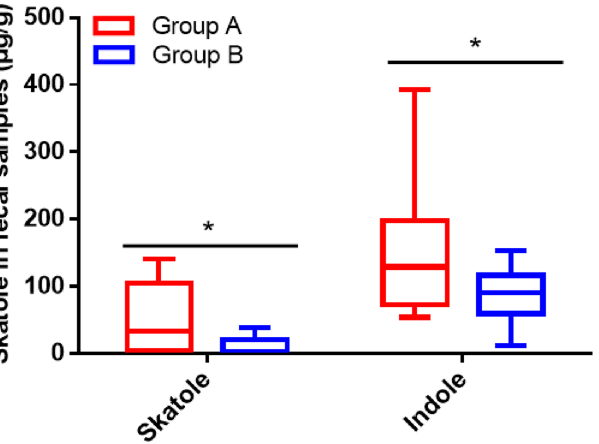
Figure 1. Chicken-eaters had higher levels of skatole and indole in feces than pork-eaters. The means were compared by Student’s t test. The asterisk (*) indicates significant difference between two groups ( P < 0.05).